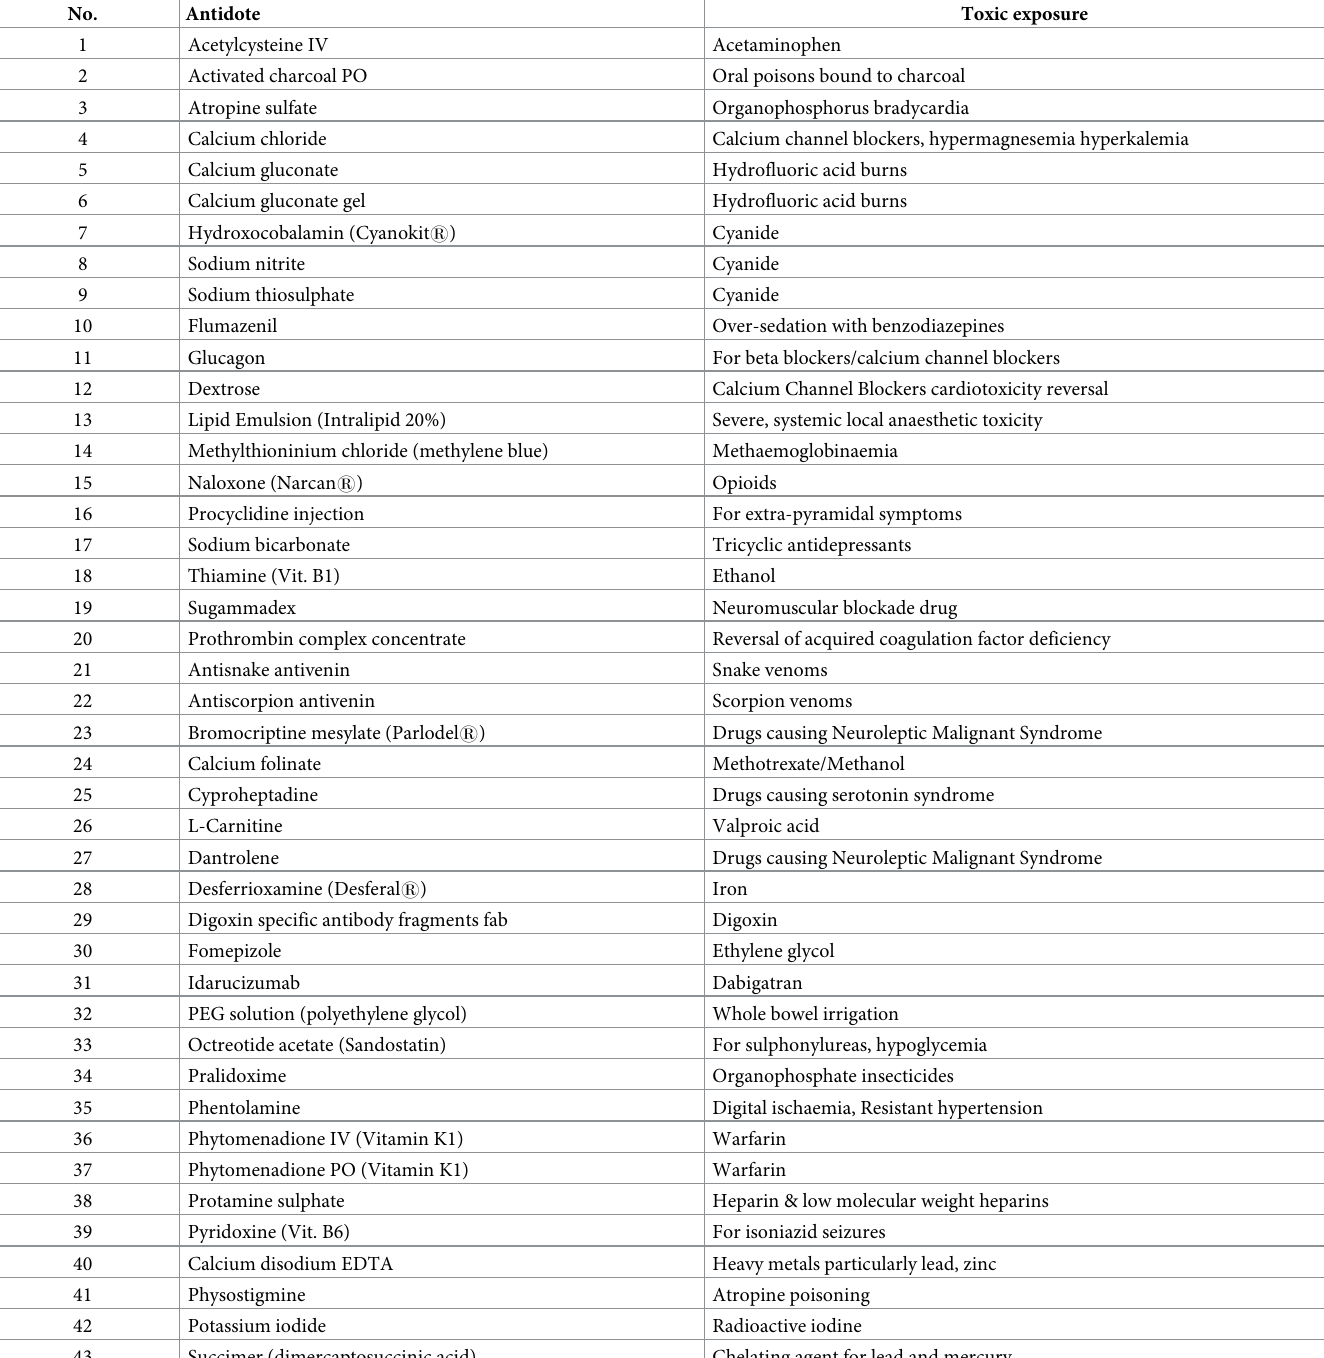
Table 3. Final list of essential antidotes for hospitals that provide emergency care services in Kuwait.